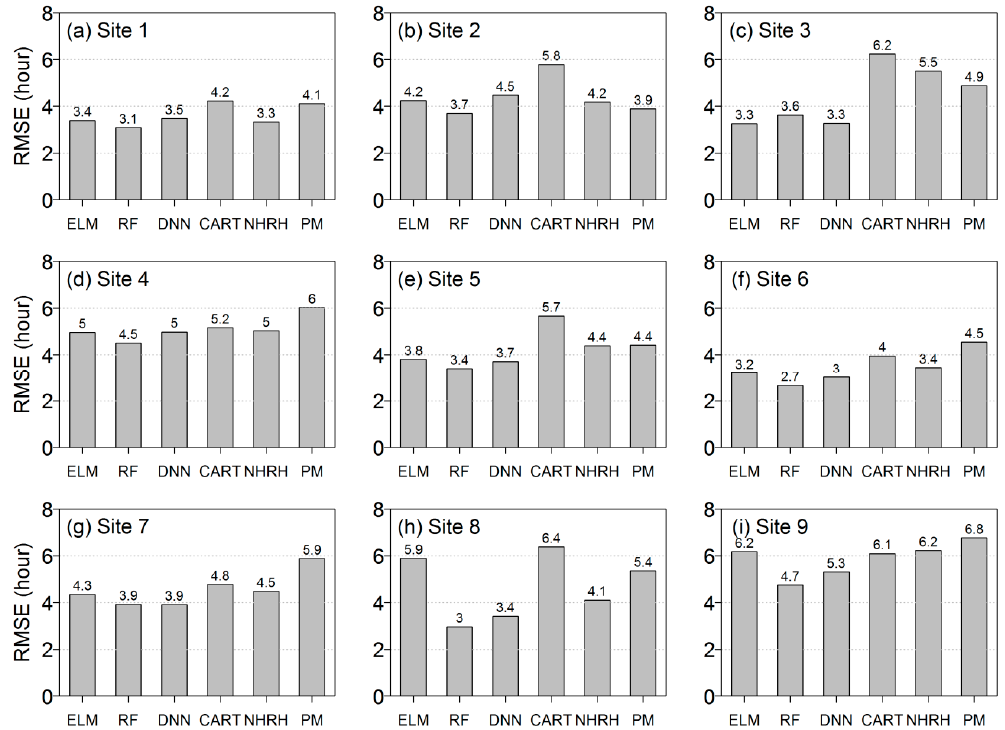
Figure 7. Root mean square errors (RMSEs) of five LWD prediction models for all employed stations. Note that the used data sets are the same as those used in Table 3.